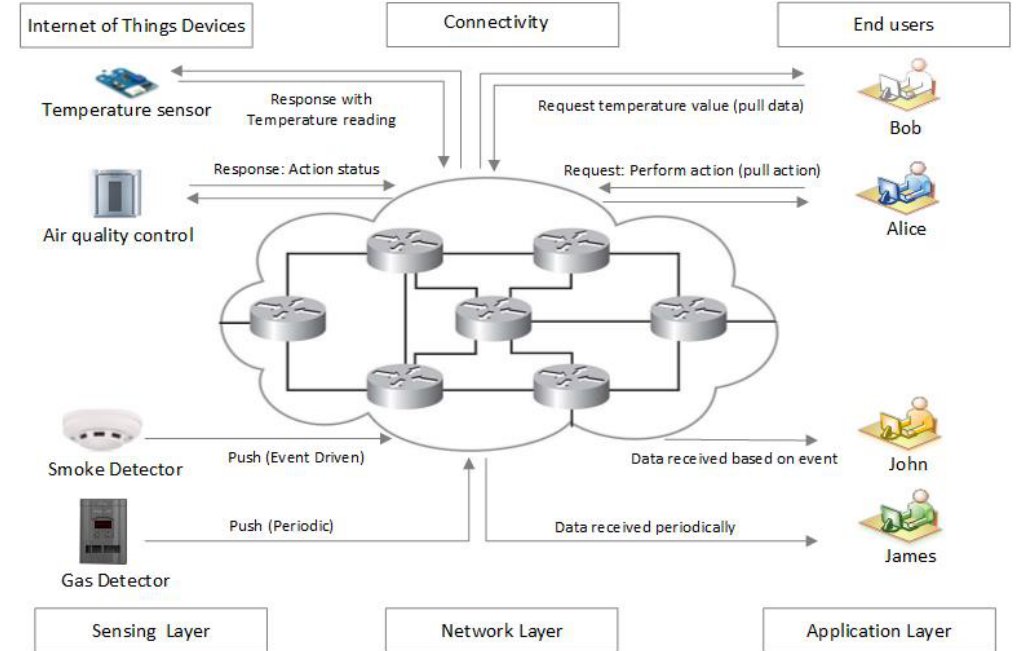
Figure 3. Smart building communication service